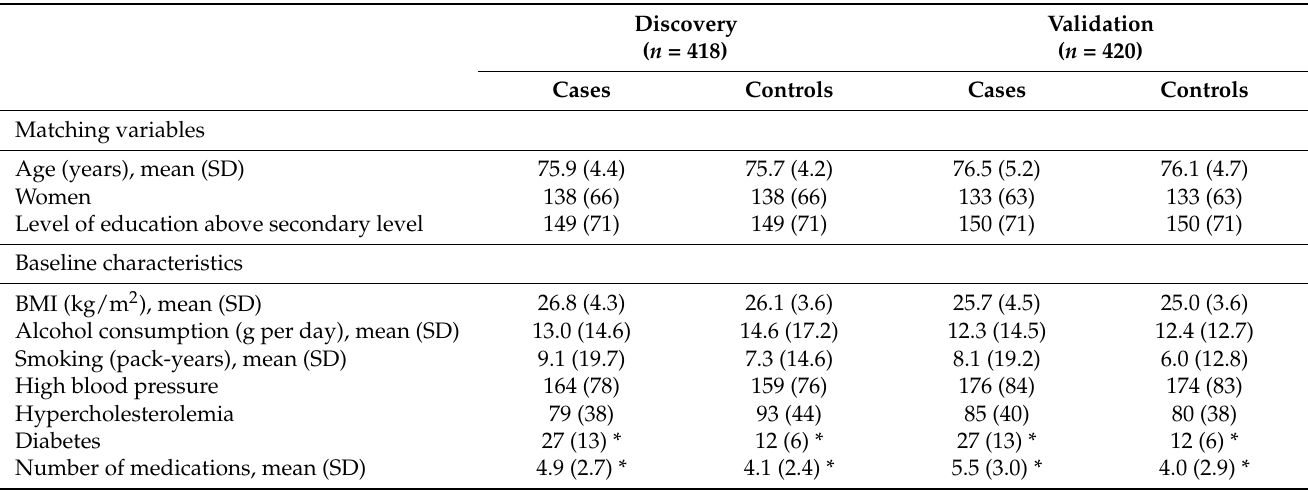
Validation ( n = 420)